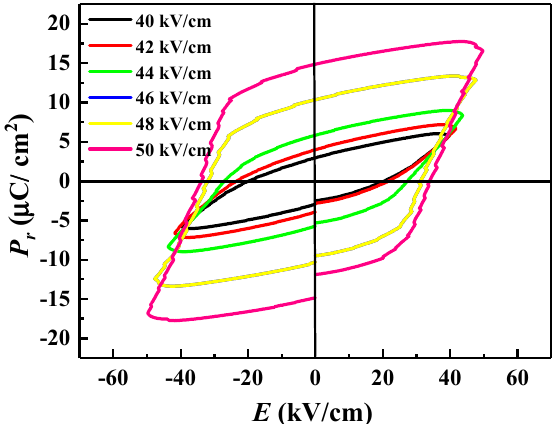
Figure 3. Polarization-electric field ( P - E ) hysteresis loops for crystals under different electric fields at room temperature.